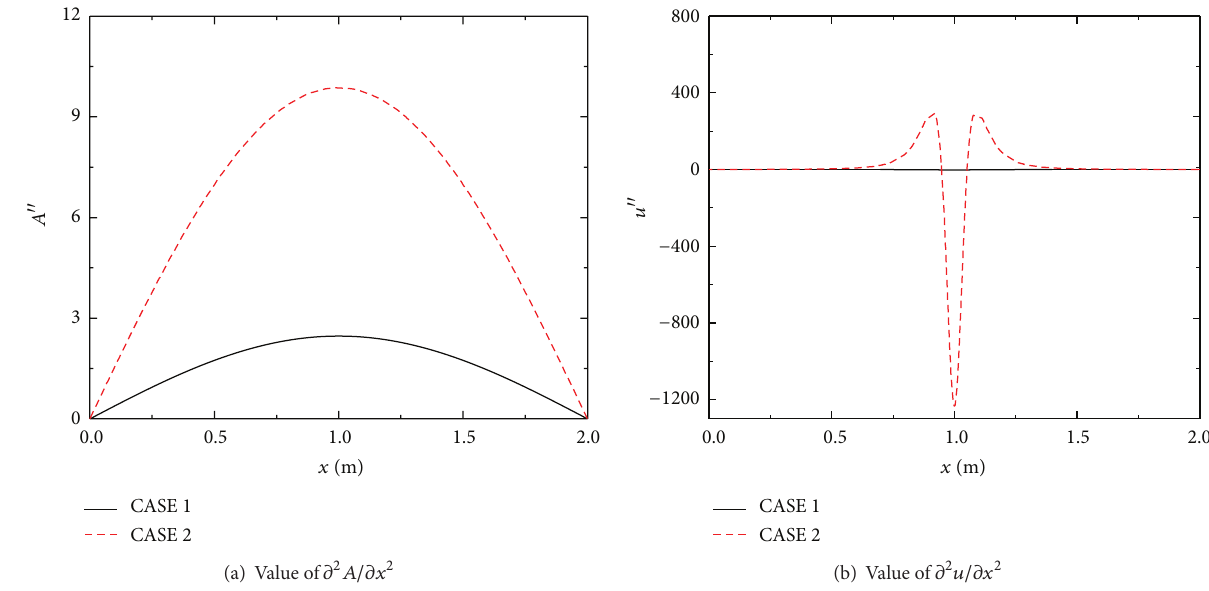
Figure 5: Values of 𝜕 2 𝐴/𝜕𝑥 2 and 𝜕 2 𝑢/𝜕𝑥 2 in CASE 1 and CASE